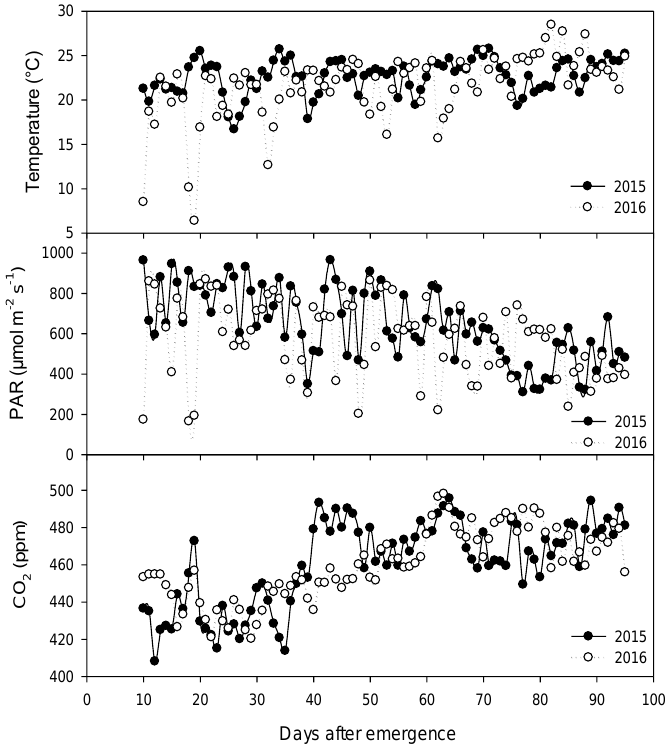
Figure 1. Climate data recorded during the development of tomato crops. The daily average is presented in the figure.